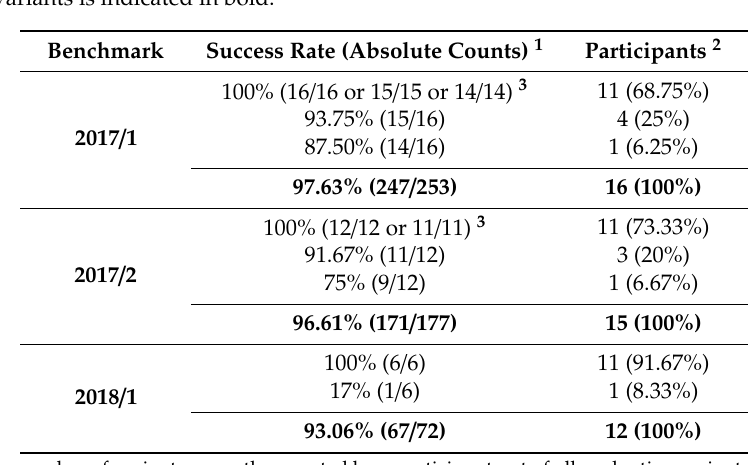
Table 5. Summarized overview of participant success rates for all three benchmarks. Results are stratified by success rates. For each benchmark, the global success rate over all participants for all evaluative variants is indicated in